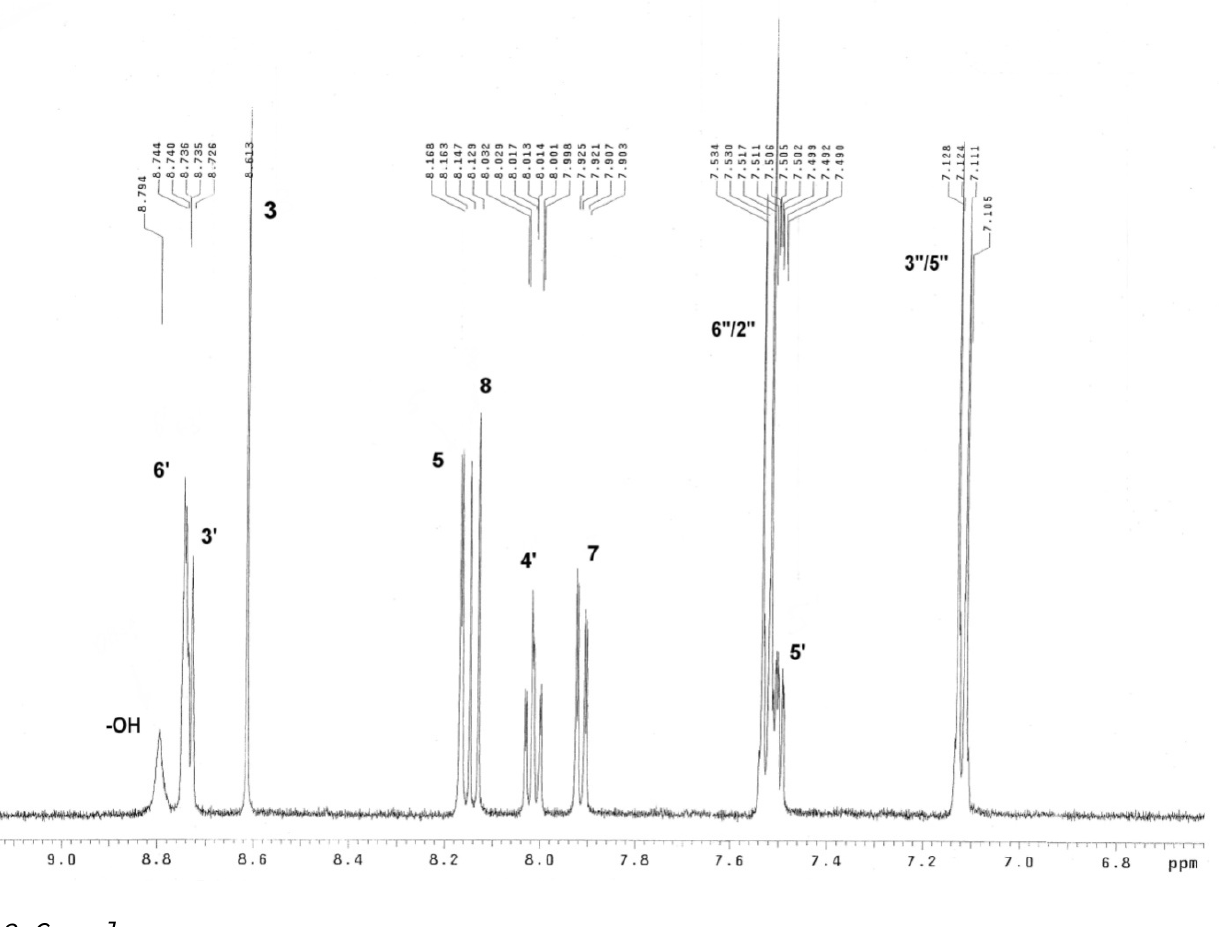
Figure 1. The 1 H-NMR spectrum (500 MHz, (CD